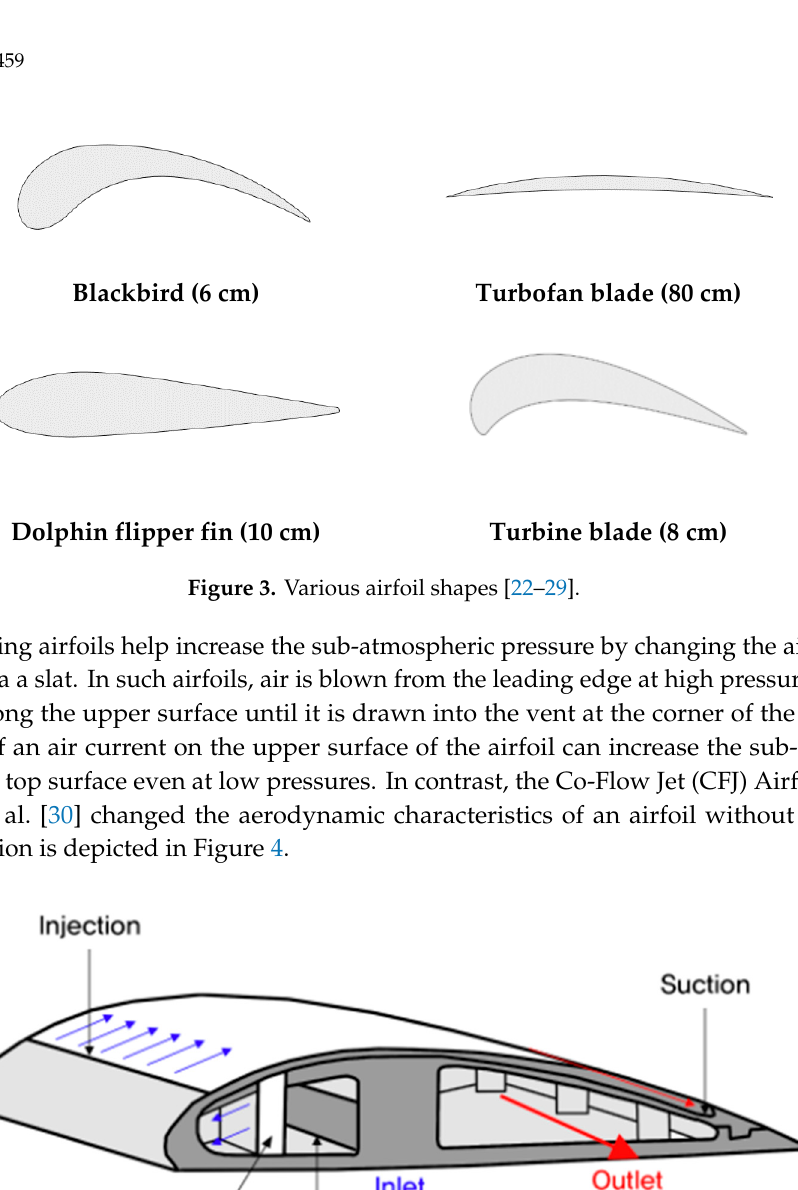
Figure 4. Operating principles of the CFJ Airfoil [30].